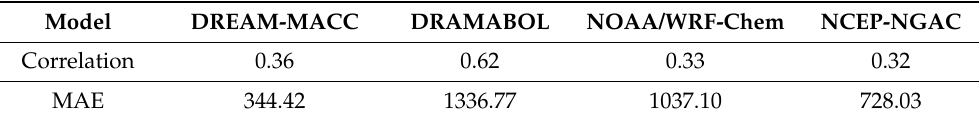
Table 4. Correlation, MAE, and RMSE errors of the output of the four models and measured PM 10 in four stations around Lake Urmia. Model DREAM-MACC DRAMABOL NOAA/WRF-Chem NCEP-NGAC Correlation 0.36 0.62 0.33 MAE 344.42